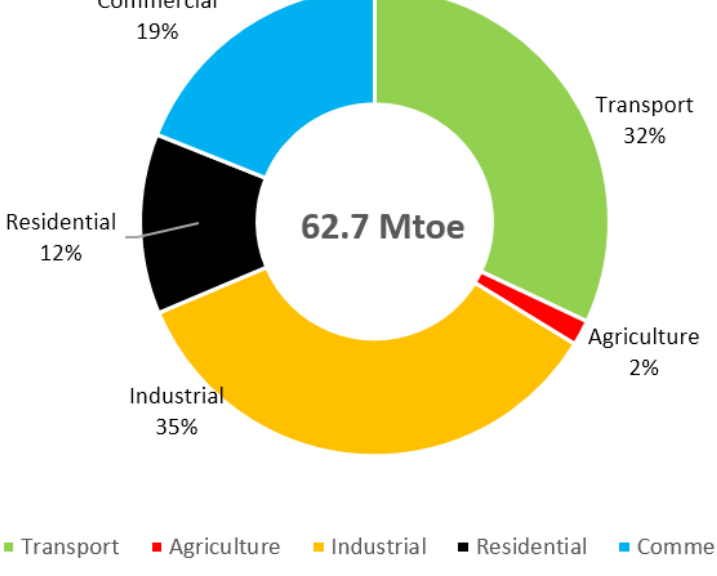
Figure 9. End energy use in each sector in Malaysia in